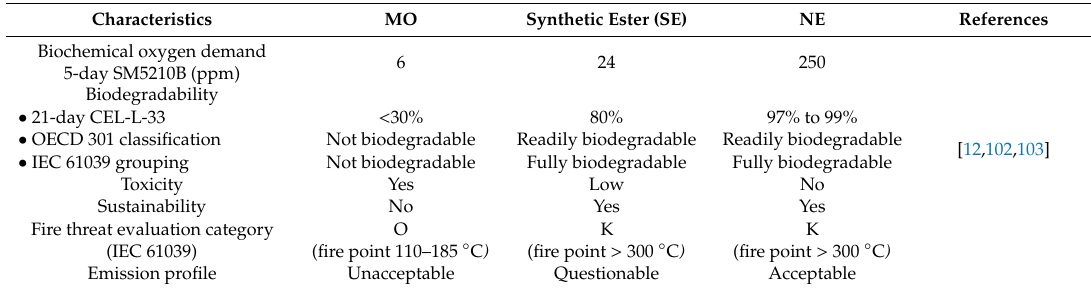
Table 17. Environmental characteristics of various insulating